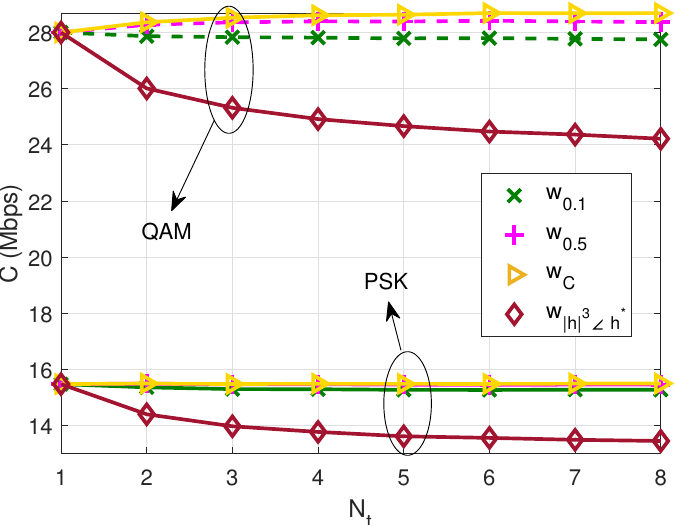
Figure 12. Capacity using multisine PSK modulation and QAM modulation with increasing number of tones, with ρ = 0.5 and B = 1